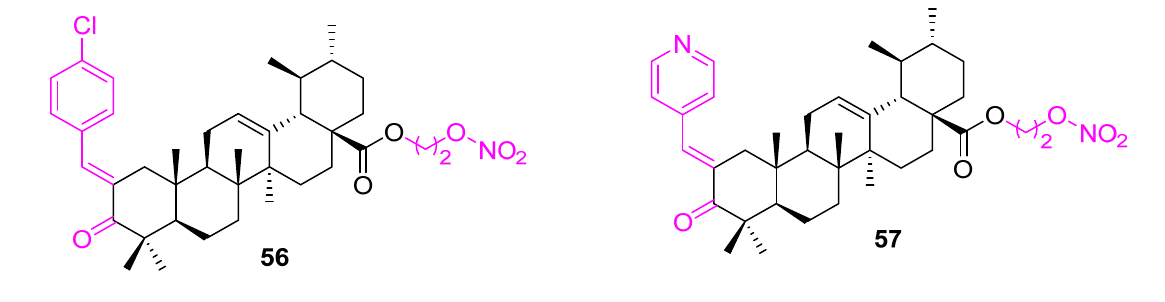
Figure 40. Structure of 58 . Secondary amines are the key building blocks of many pharmaceutically active com- pounds, such as gefitinib and imatinib [126,127]. Wang et al. introduced the piperazine and morpholine rings at the C3 position of a modified UA via a linker. The piperazine- containing analog 59 (Figure 41) was identified as being more potent against three differ- ent cancer cell lines than the morpholine-containing one, 60 [128].